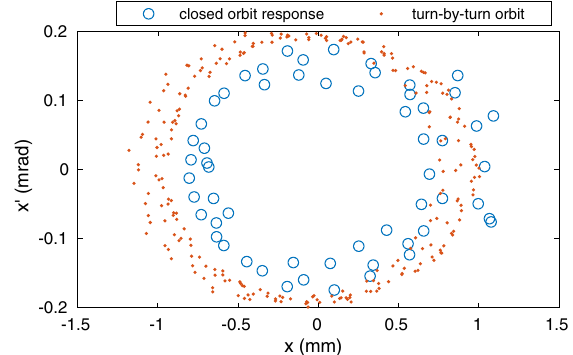
FIG. 1. Comparison of closed orbit responses with 58 correc- tors and TBT orbits for 256 turns in phase space.